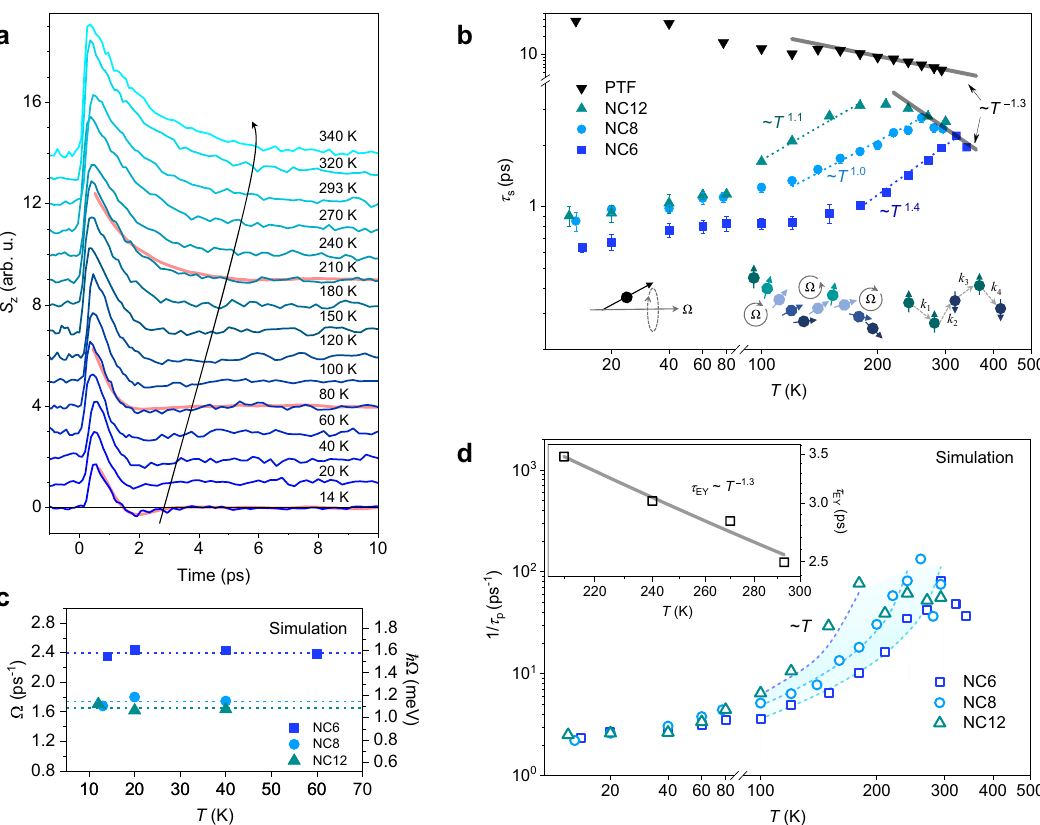
Fig. 3 | Temperature dependences of the exciton spin lifetime in CsPbBr 3 NCs with resonant pumping and low excitation density. a The net spin polarization dynamics at different temperatures for NC6 (for clarity, S z here is fl ipped to decay from a positive value).The simulateddynamics are selectively shown at14K,80K, and 210K by red lines. b Extracted exciton spin lifetimes atdifferent temperatures for NCs with three sizes and polycrystalline thin fi lm. The error bars represent the standard errors of the fi tted spin lifetimes. The gray lines with a power-law expo- nent of − 1.3 are plotted for guidance. From left to right, the insets schematically show the spin precession along an effective magnetic fi eld with a frequency of Ω ,